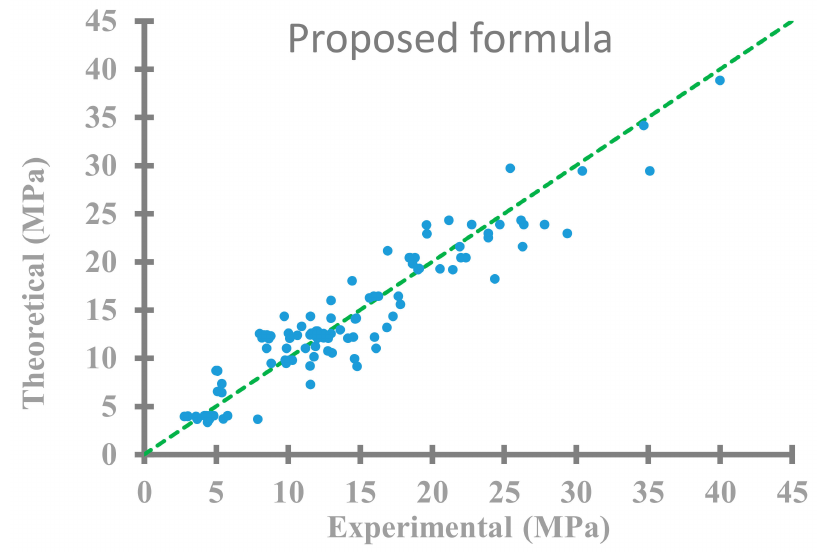
Figure 13. Theoretical and experimental behavior of the proposed